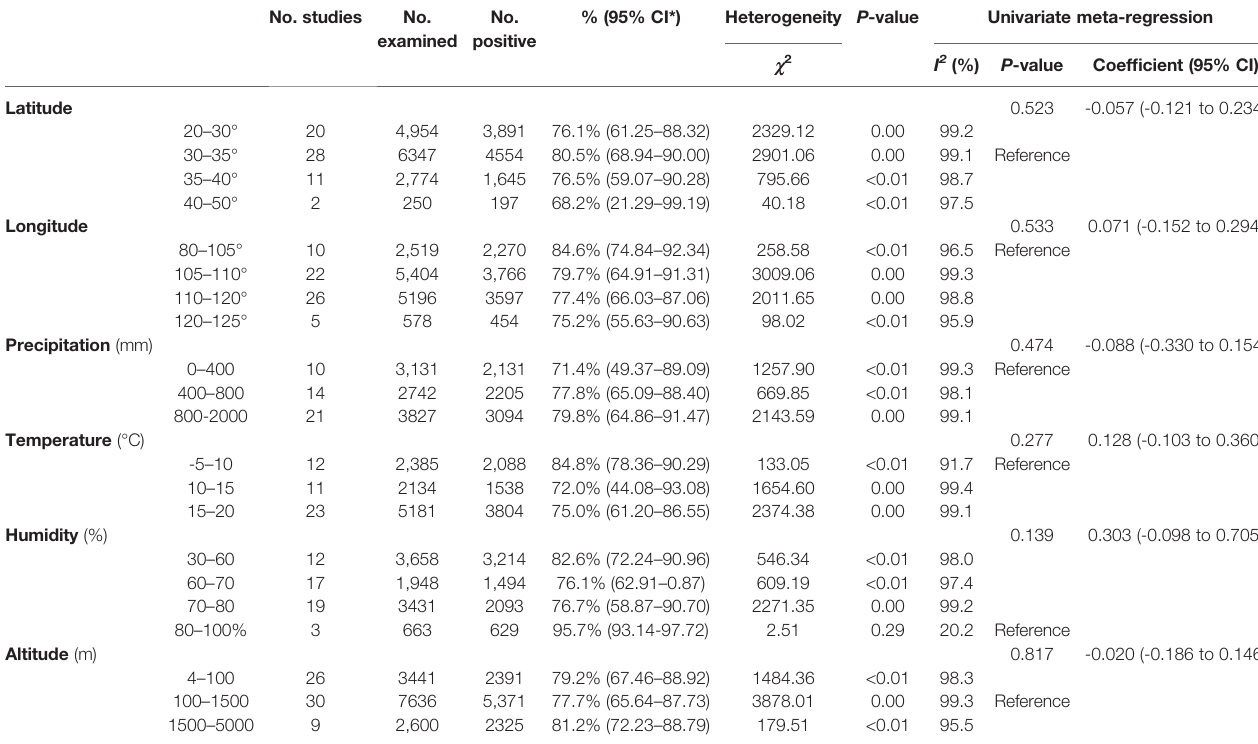
TABLE 5 | Subgroup analysis of the prevalence of Eimeria spp. according to geographic location and climatic variables. No.